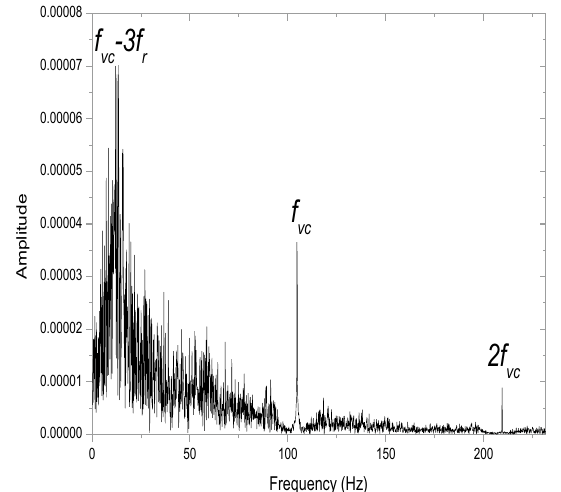
Fig. 11 Bifurcation diagram of response Y vs. gap; S means the rela- tively stable region; U means the relatively unstable region